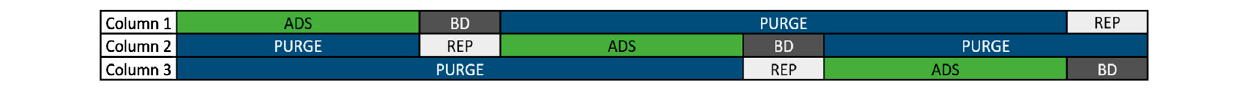
FIGURE 4 | Three-column cycle design for the four-step SEDMES process with (ADS) adsorption step, (BD) blowdown step, (PURGE) purge step, (REP) repressurization step.